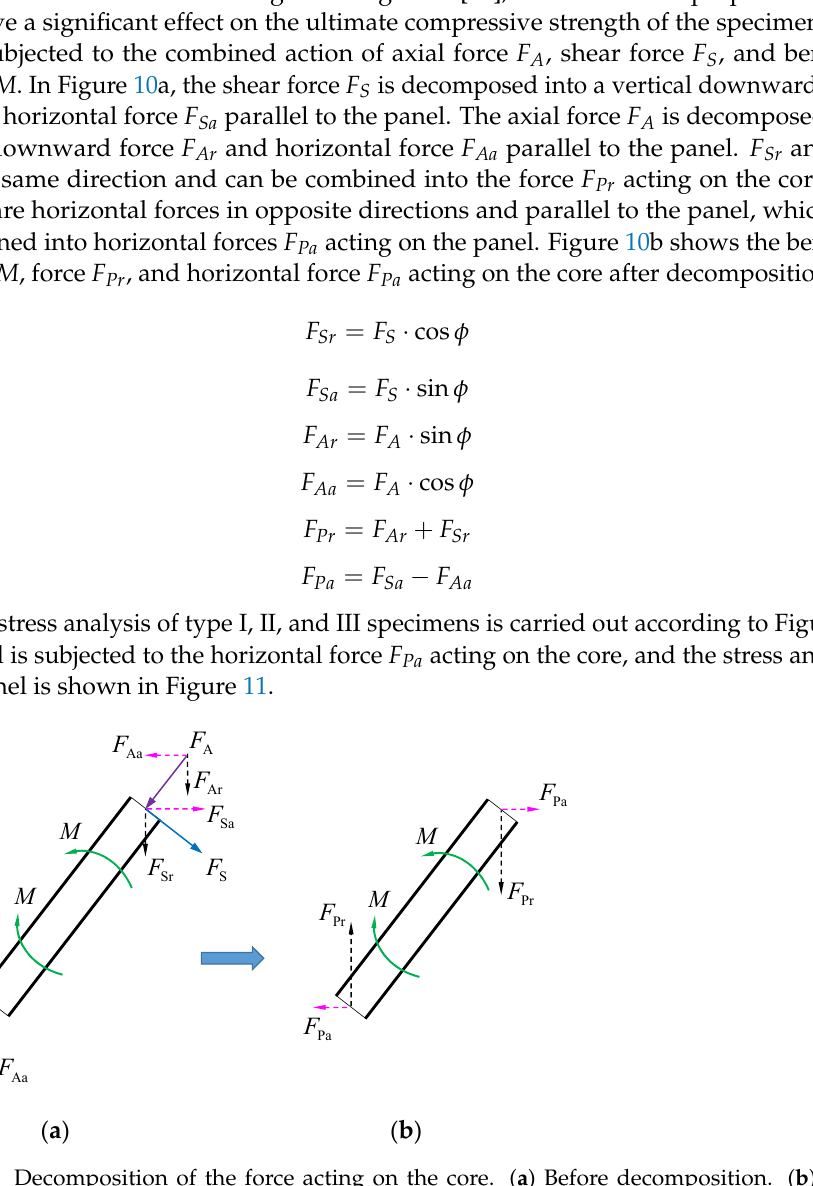
Figure 10. Decomposition of the force acting on the core. ( a ) Before decomposition. ( b ) After decomposition.